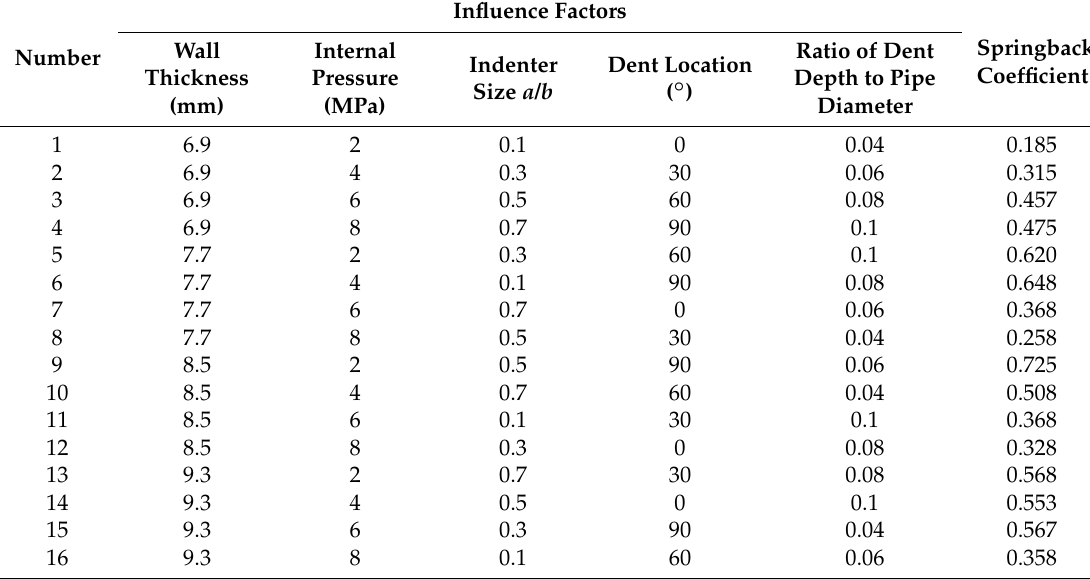
Table 3. Orthogonal test design tables for various influencing